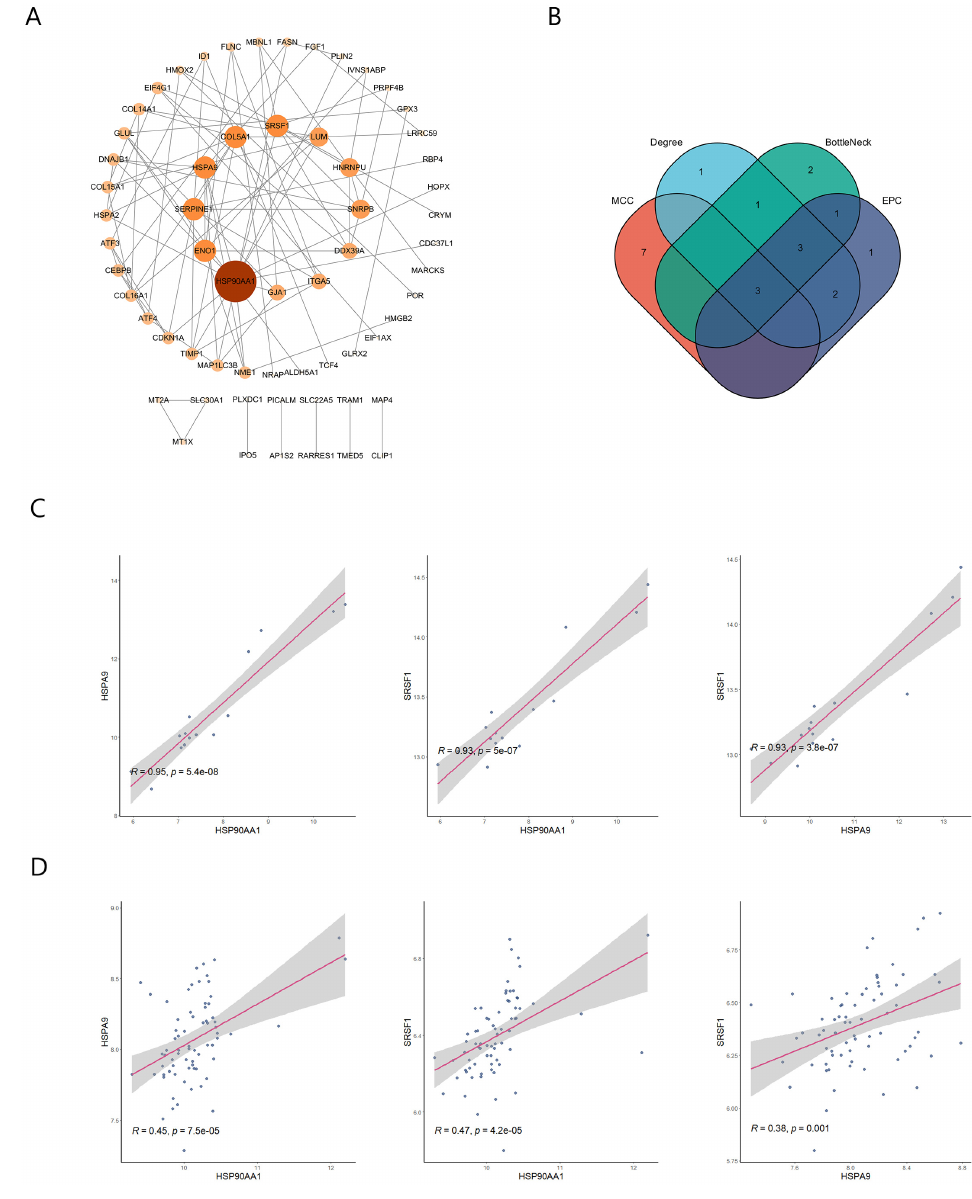
Figure 4. Detection of hub genes by protein–protein interaction network analysis. ( A ) Protein–protein interaction network. The greater the degree of connectivity (degree) between a gene and other genes, the larger the node area and the darker the color. ( B ) Screening of the top 10 hub genes in the network using the MCC, EPC, Degree, and BottleNeck methods in the cytoHubba plugin. ( C ) Correlation of hub genes in the GSE164805 dataset. ( D ) Correlation of hub genes in the GSE5406 dataset.